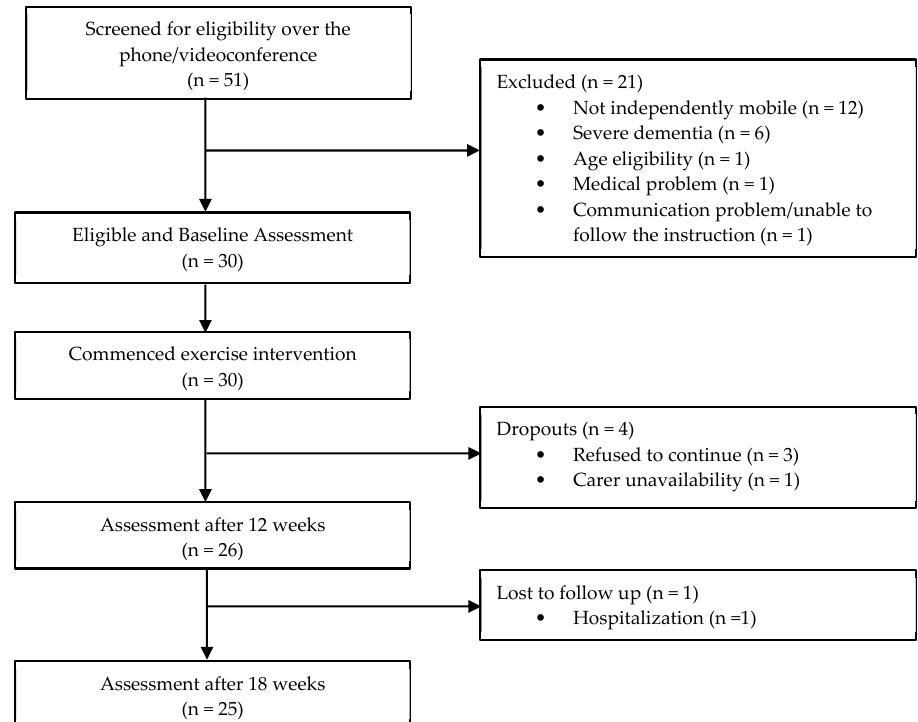
Figure 1. Flow diagram of recruitment and attrition. Table 2. Characteristics of the participants at baseline.